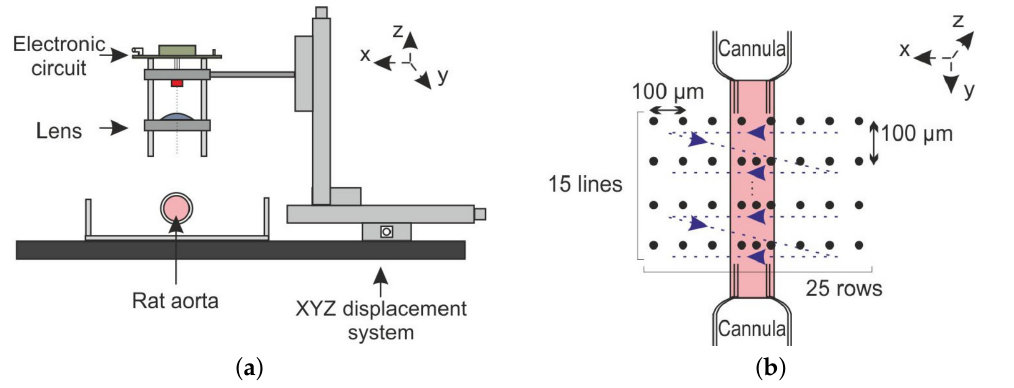
Figure 22. Aorta Doppler scanning system: ( a ) lateral view of the sensor scanning system; ( b ) top view of the aorta scanning